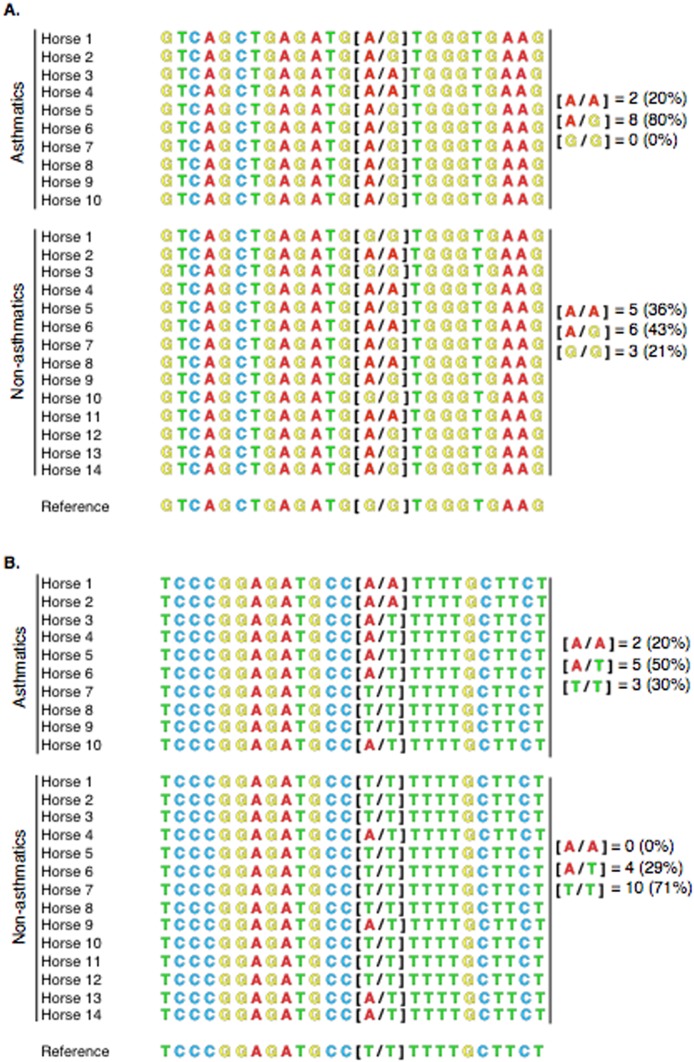
Alignment of PACRG (A) and RTTN (B) Sanger sequences for 10 asthmatic and 14 non-asthmatic horses with the reference genome.(A) For PACRG, eight asthmatic horses (80%) were heterozygous [A/G], 2 (20%) were homozygous mutant [A/A] and none was homozygous wild-type [G/G]. Six non-asthmatic horses (43%) were heterozygous [A/G], 5 (36%) were homozygous mutant [A/A] and 3 (21%) were homozygous wild type [G/G]. (B) For RTTN, in the asthmatic group, there were 5 (50%) heterozygous [A/T], 2 (20%) homozygous mutant [A/A], and 3 (30%) homozygous wild type [T/T] genotypes. In the non-asthmatic group, 4 (29%) were heterozygous [A/G], 10 (71%) were homozygous wild type [T/T], and none had the homozygous mutant [A/A] genotype.